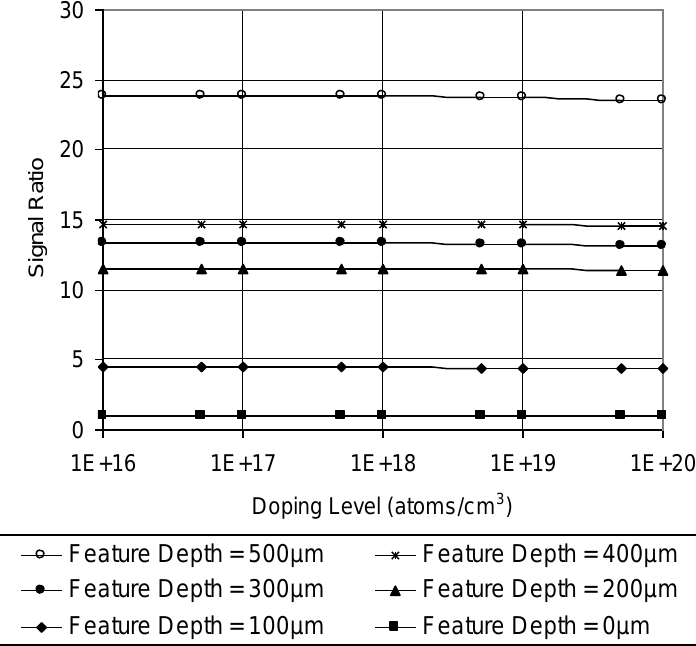
Figure 25. Effect of geometric feature depth on the sensor signal ratio (longitudinal sensitivity/transverse sensitivity) at different doping concentrations, V the signal ratio is